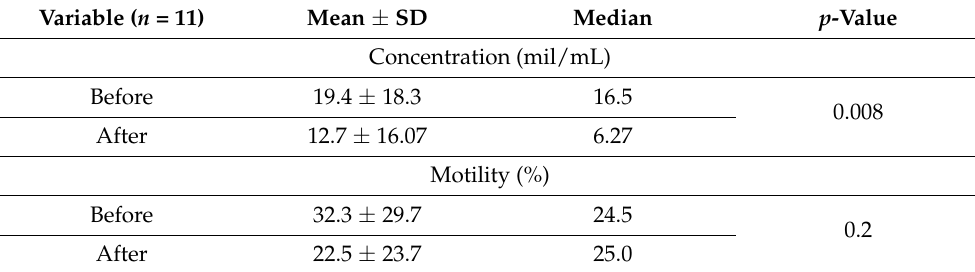
Table 2. Sperm parameters of exposed male partners: pre- and post-COVID-19 disease.